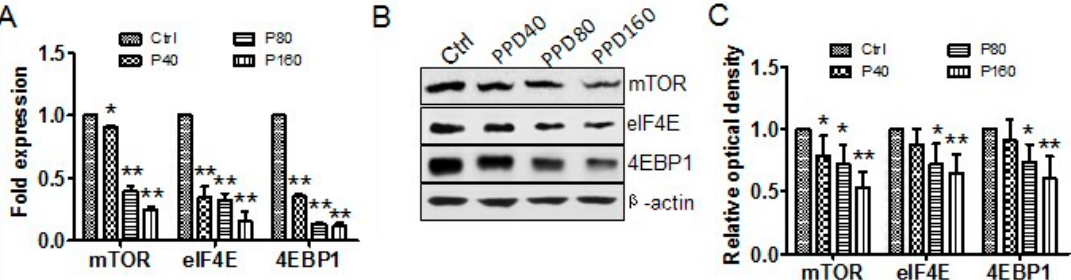
Figure 4. PPD affects the transcription and expression of mTOR and its downstream